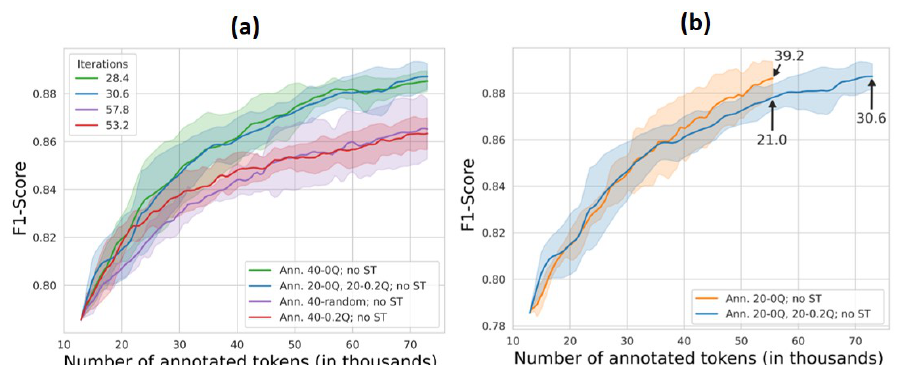
Figure 7. Evolution of model performance (F1-score) with training iterations when ( a ) different sets of sentences are selected for manual annotation (see Table 3 for a description of the different experiments conducted). Self-learning was performed in none of the cases. The same is depicted in ( b ) but only two different selections are compared in this